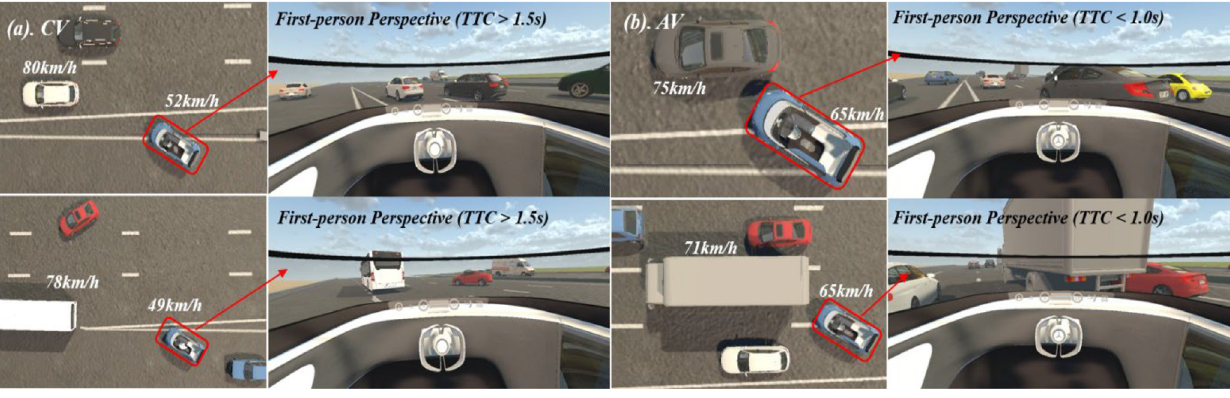
Figure 12 Difference of the hazard perception between CV and AV modes